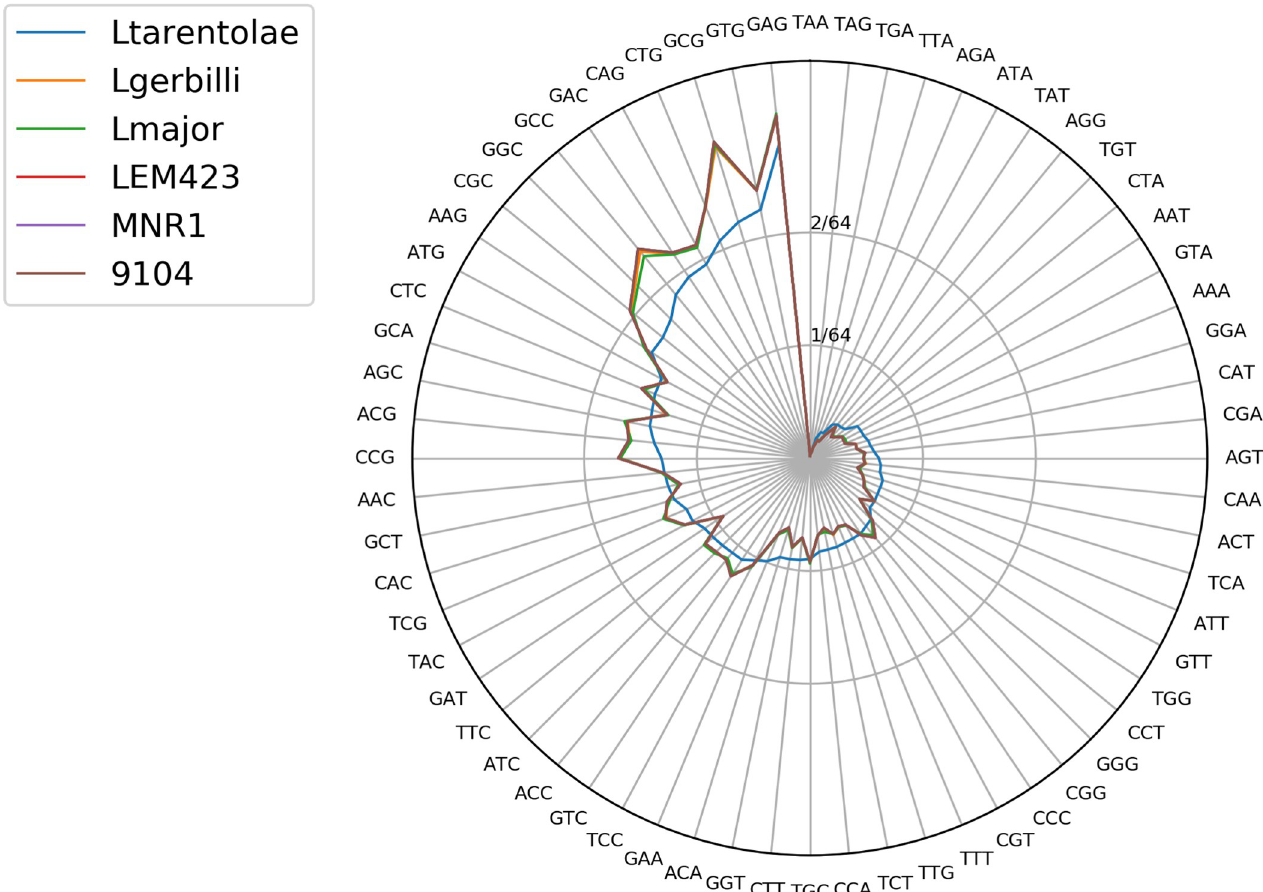
Fig 3. Codon usage plot. Codon frequencies for each of 64 triplets are plotted for Leishmania tarentolae Parrot-TarII (‘Ltarentolae’), L . gerbilli LEM452 (‘Lgerbilli’), L . major Friedlin (‘Lmajor’), L . turanica LEM423 (‘LEM423’), L . turanica MNR1 (‘MNR1’), and L . turanica 9104 (‘9104’).